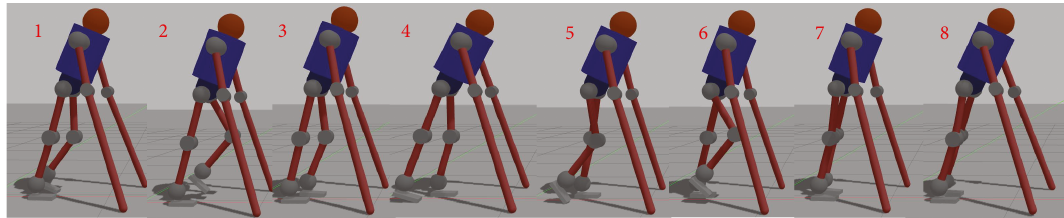
Figure 6: Snapshot of simulation during